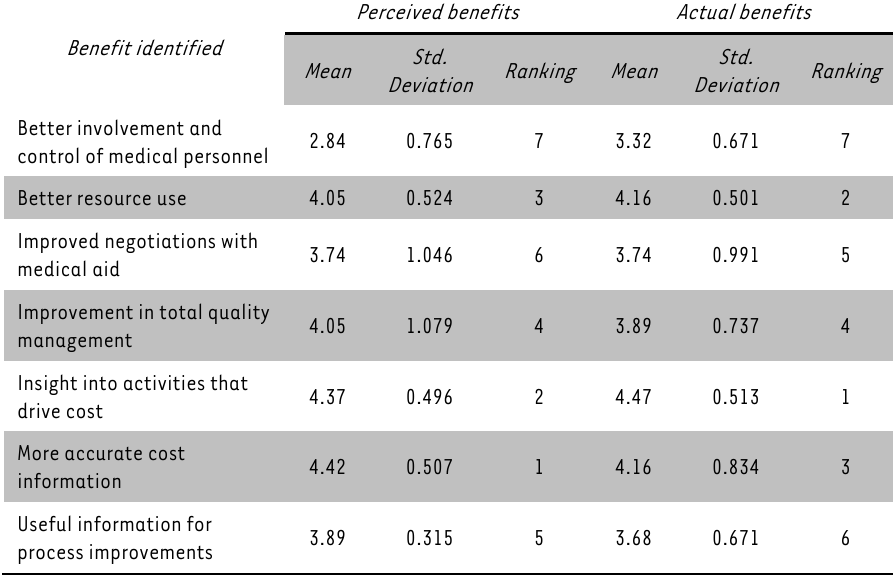
TABLE 2: Perceived and actual benefits as reported by respondents who adopted ABC Benefit